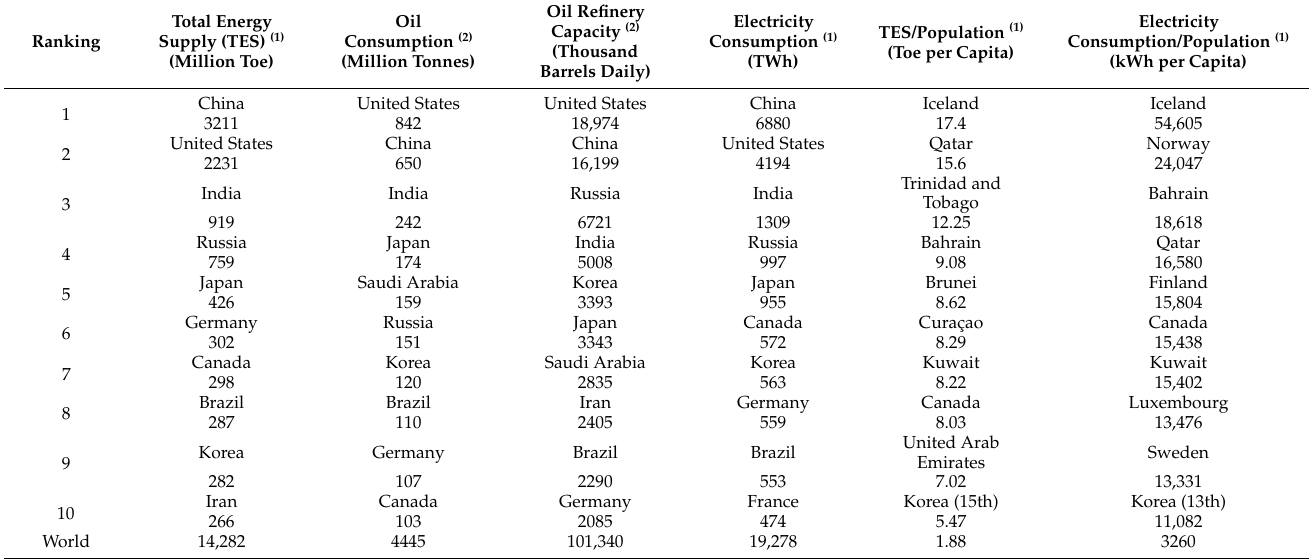
Table 3. Country comparison of energy consumption [43] (1) [44] (2)